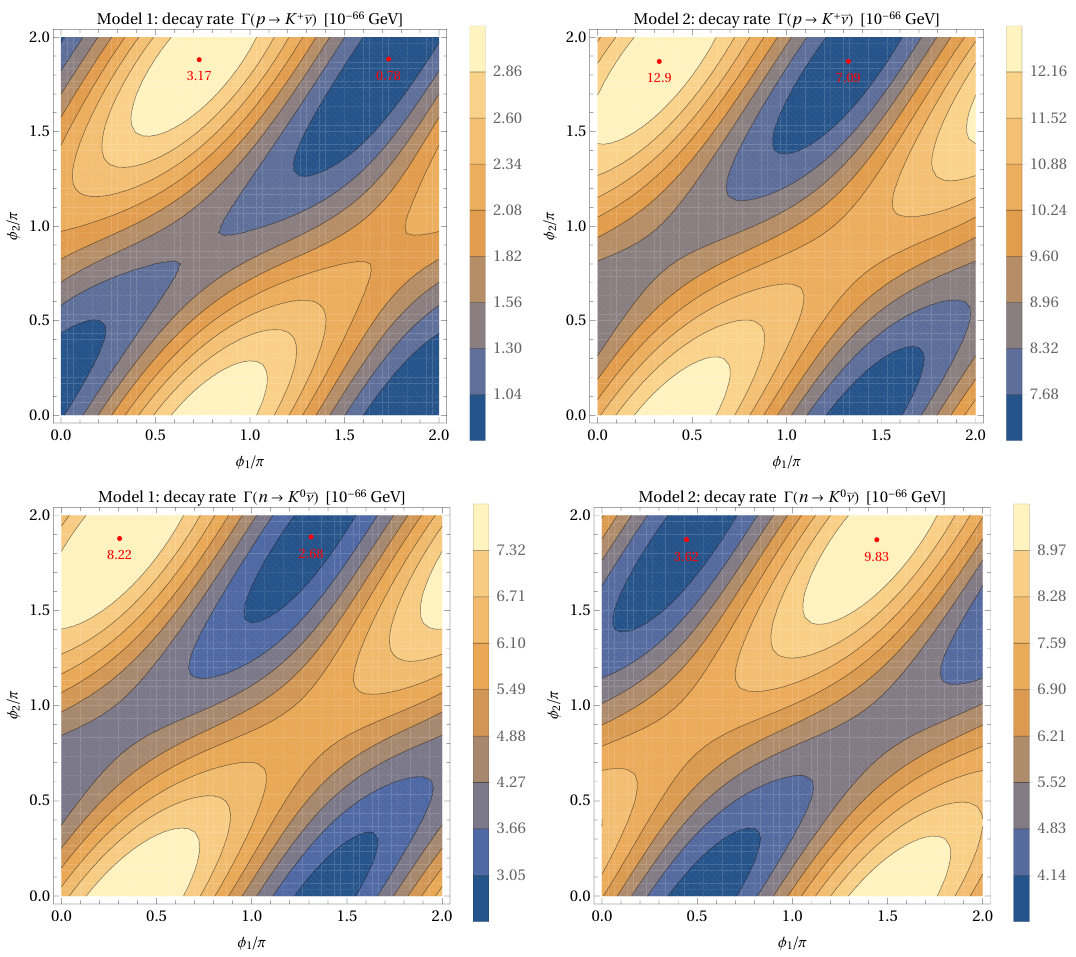
Figure 1 . Contour plots for the GUT phase dependence of the dominant proton decay channel p → K + ¯ ν (top) and neutron decay channel n → K 0 ¯ ν (bottom) for the best-fit points of model 1 (left) and model 2 (right). We assumed M eff = 10 19 GeV T